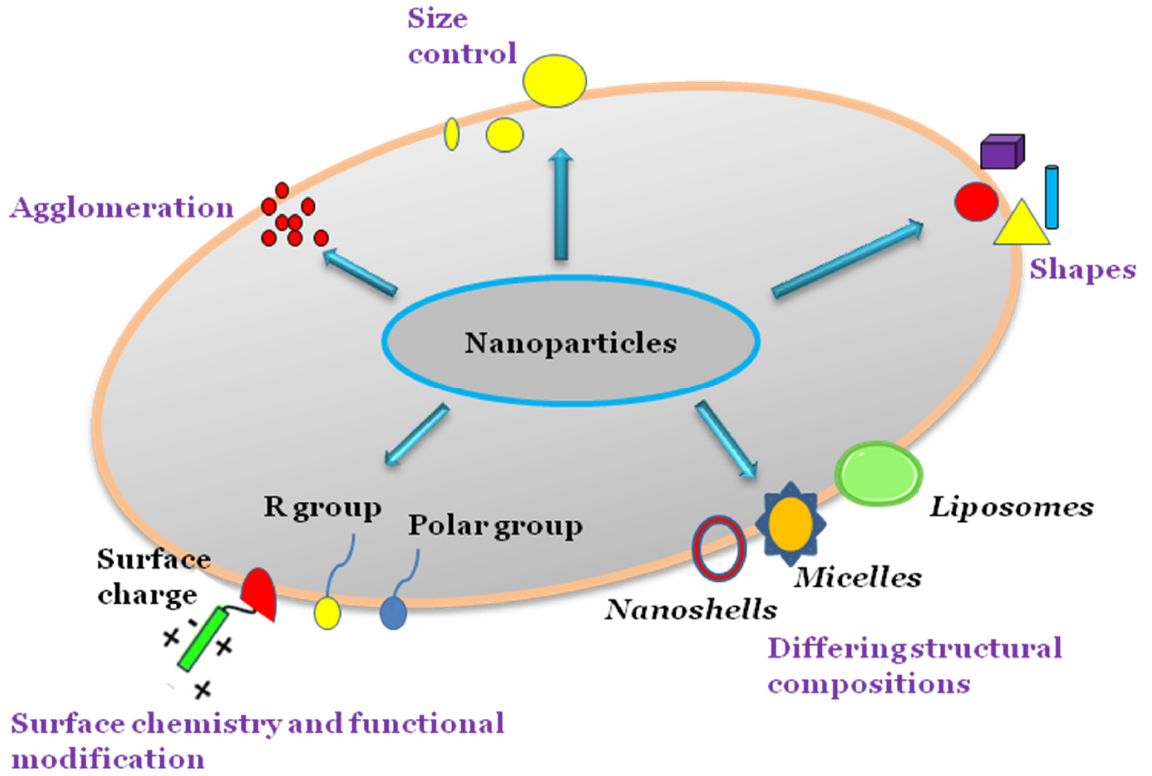
Figure 1. Physicochemical properties of nanoparticles.